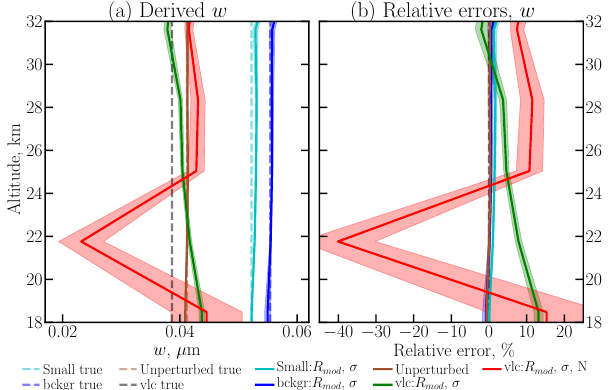
Figure 6. Absolute distribution width, w , profiles (a) and their rela- tive errors (b) for a typical tropical observation geometry. The solid lines show the retrieval results, while the dashed lines represent the true values. The shaded areas stand for ± 1 standard deviation. The scenarios used for the simulations are listed in Table 1.